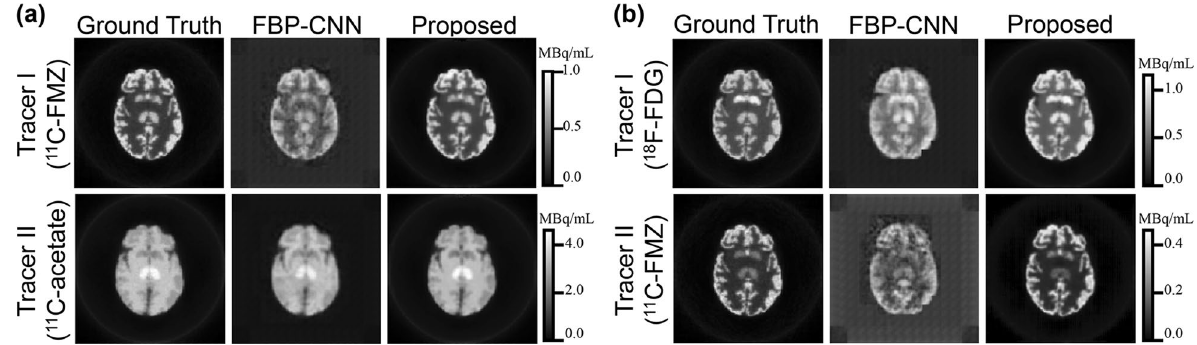
Fig. 4 The representative reconstructed images from the tracer combination experiment. a Tracer combination I ( 11 C-FMZ/ 11 C-acetate), b Tracer combination II ( 18 F-FDG/ 11 C-FMZ). These images show the 10th frame of the dynamic images